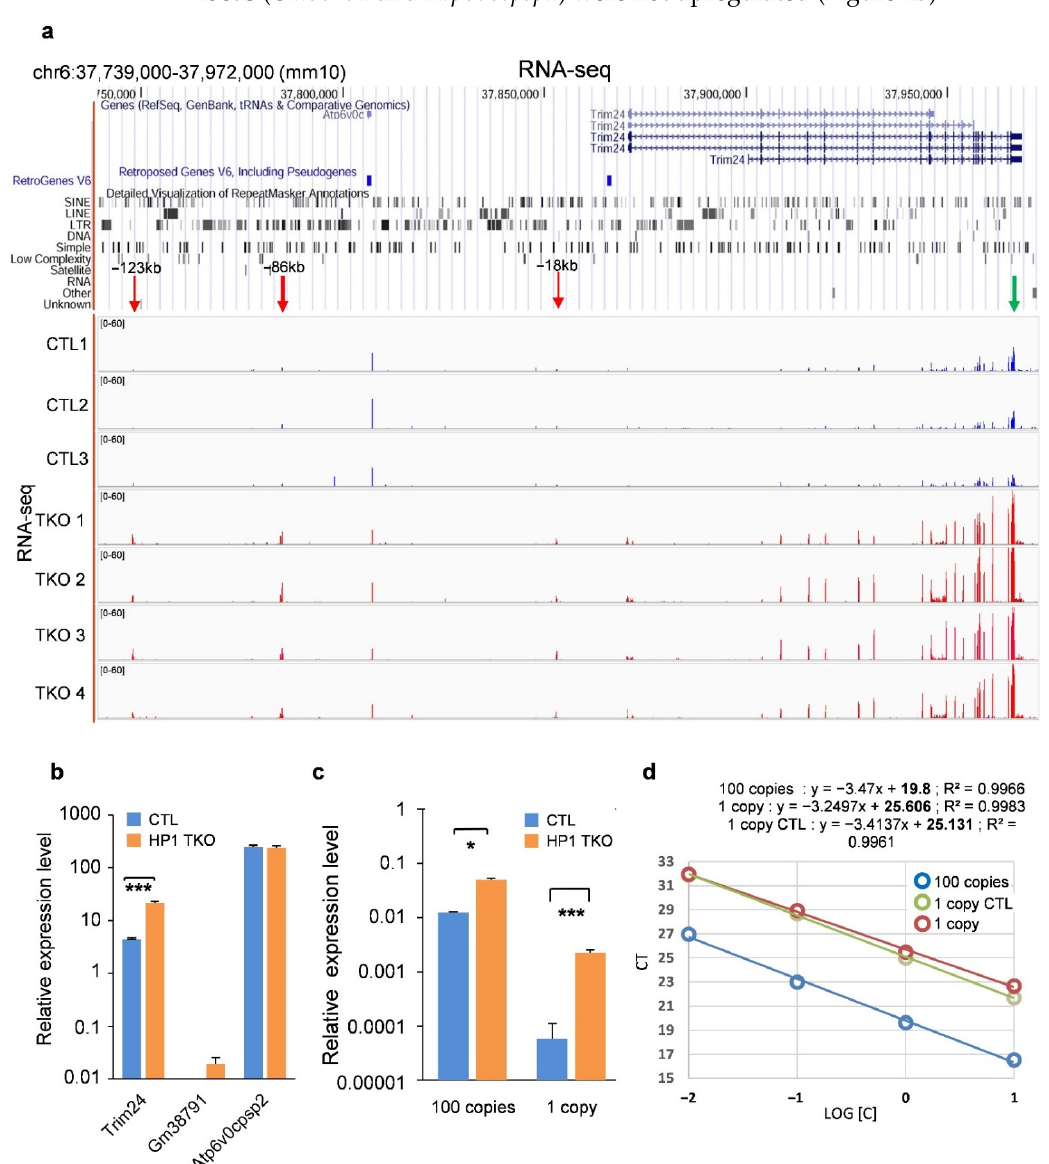
Figure 2. HP1 proteins control the expression of Trim24 upstream ERV sequences. ( a ) Genome Browser snapshot of RNA-seq data at the Trim24 locus. Trim24 mRNA levels were found to be highly increased in the HP1-TKO compared to control livers. Upregulation was particularly clear for the last exons (green arrow on the right). One intergenic sequence, located 86 kb upstream of the Trim24 promoter, was found to be highly de-repressed in the HP1-TKO compared to control livers (large red arrow on the left). Two other regions, located 123 kb and 18 kb upstream of the Trim24 promoter, were also found to be de-repressed (faint red arrows on the left). ( b ) RT-qPCRs were performed on total RNA from three HP1-TKO (201, 248 and 316) and three control (202, 251 and 315) (CTL) mouse liver samples, using primers targeting Trim24 exon 19, Gm38791 and Atp6v0cpsp2 transcripts. RNA levels were normalised relative to Gapdh mRNA levels. We observe a significant difference in expression level between the two conditions only for Trim24 . Error bars represent the s.e.m. of three biological replicates. p -value < 0.01 (***), (Student’s t -test). ( c ) Primer pairs binding to 1 copy of RLTR6-18 ERV or 100 copies of RLTR6-86 ERV Trim24 upstream sequences were used in RT-qPCR experiments